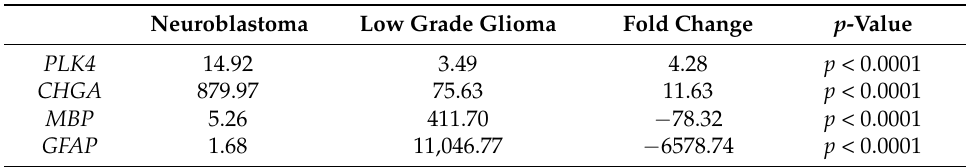
Table 3. Expression of PLK4 , CHGA , MBP and GFAP obtained from the GDC. Genes displayed are: PLK4 (polo-like kinase 4), CHGA (chromogranin A), MBP (myelin basic protein) and GFAP (glial fibrillary acidic protein). Expression is represented as average TPM (Transcripts per million) values. Statistics were calculated in PRISM (unpaired t -test; p <